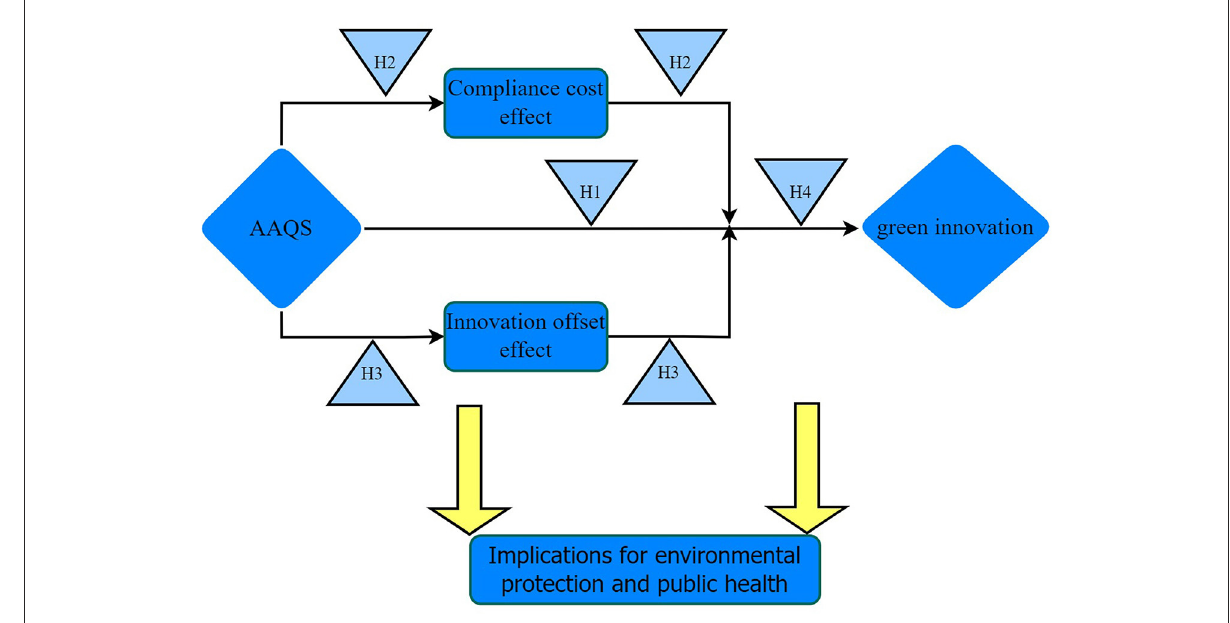
FIGURE3 Theoretical framework